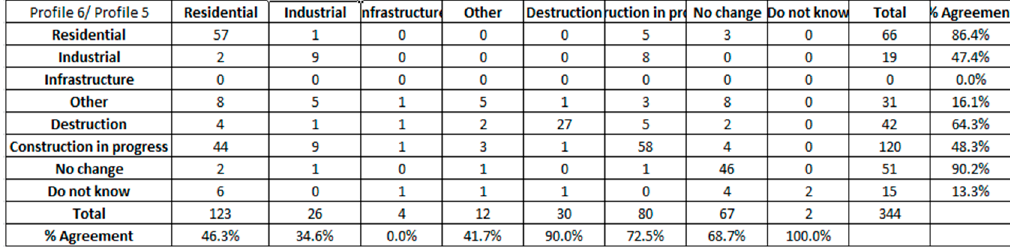
Figure 17. Confusion matrix between Profile 6 (non-expert administrative staff) and Profile 5 (Land Use Land Cover (LULC) experts).